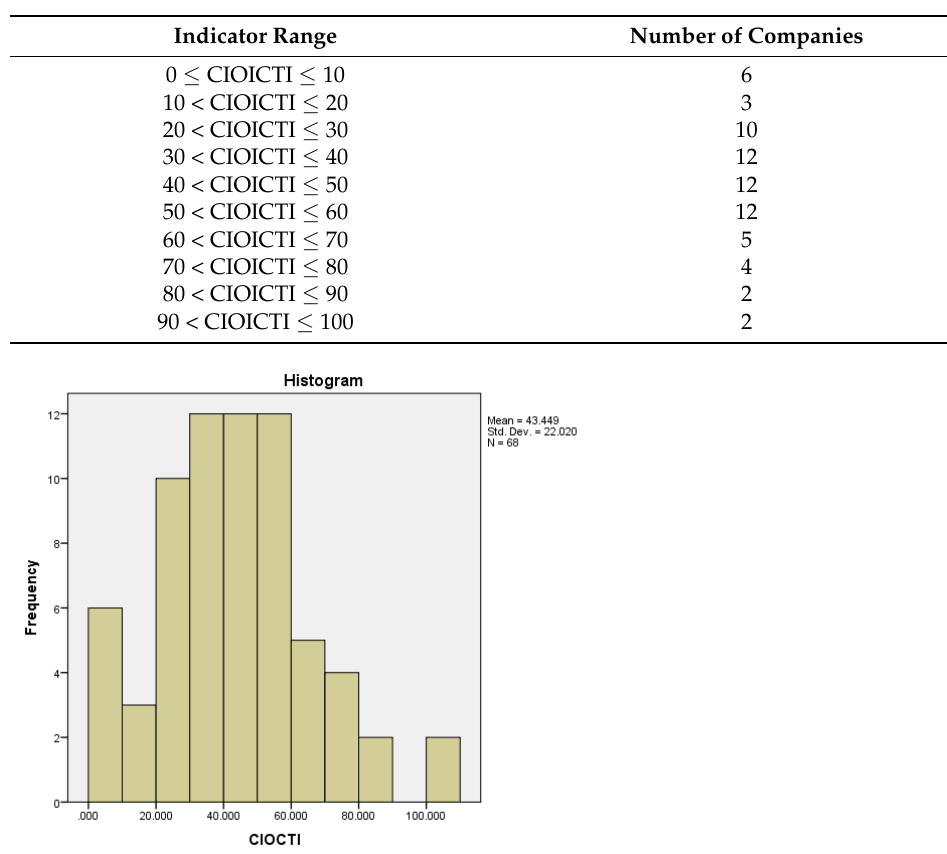
Table 11. The distribution of the CIOICTI values on the observed data sample.